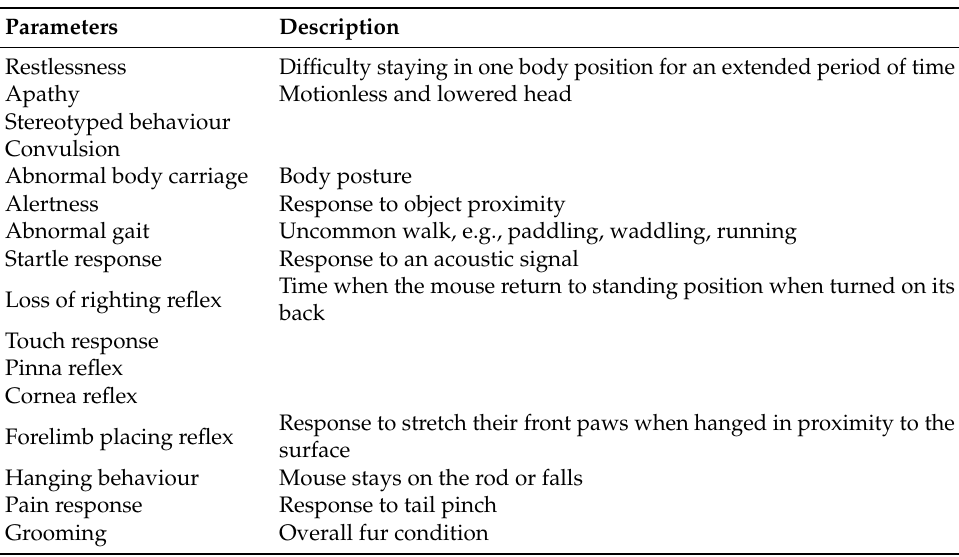
Table 1. Evaluated Parameter on the SHIRPA